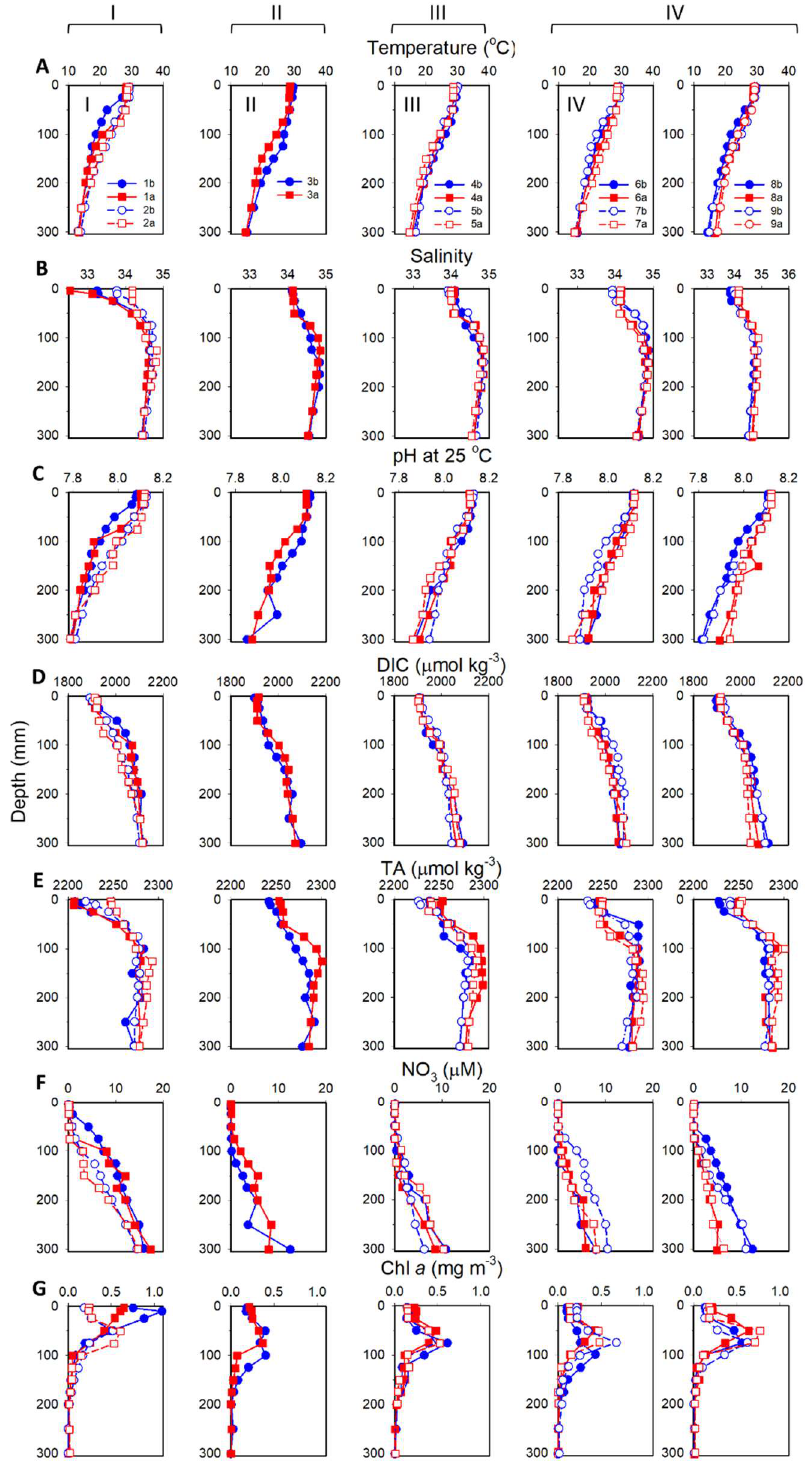
Figure 3. Comparison of the vertical distributions of ( A ) temperature, ( B ) salinity, ( C ) pH at 25 °C, ( D ) dissolved inorganic carbon (DIC), ( E ) total alkalinity (TA), ( F ) NO 3 , and ( G ) Chl a concentration at the nine hydrological stations before (blue symbols) and after the typhoon (red symbols) passage. The nine stations were grouped into four subzones based on the p CO 2 variations before and after typhoon passage (Zone I, stations 1 and 2; Zone II, station 3; Zone III, stations 4 and 5; and Zone IV, stations 6, 7, 8 and 9; see text for the details).